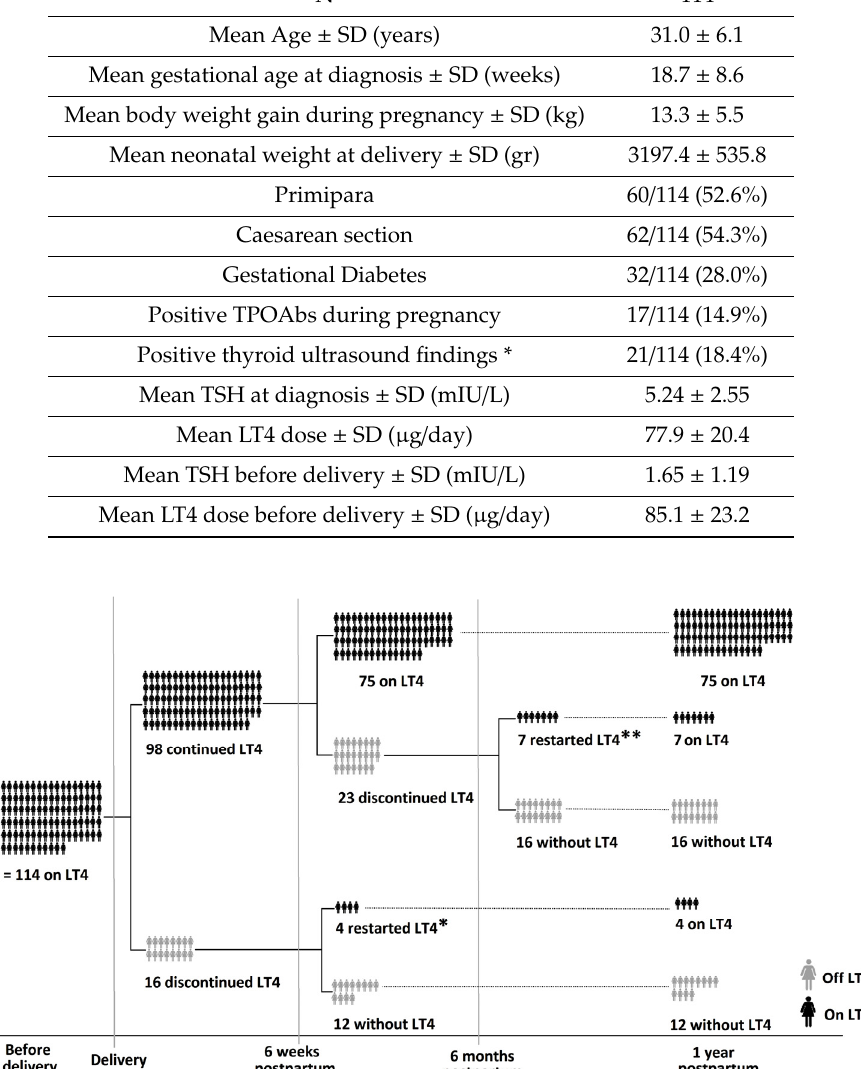
Table 1. Demographic characteristics, clinical data, and laboratory findings of the study group; * enlargement, inhomogeneity, hypoechogenicity, or diffusely increased vascularization of the thyroid gland.